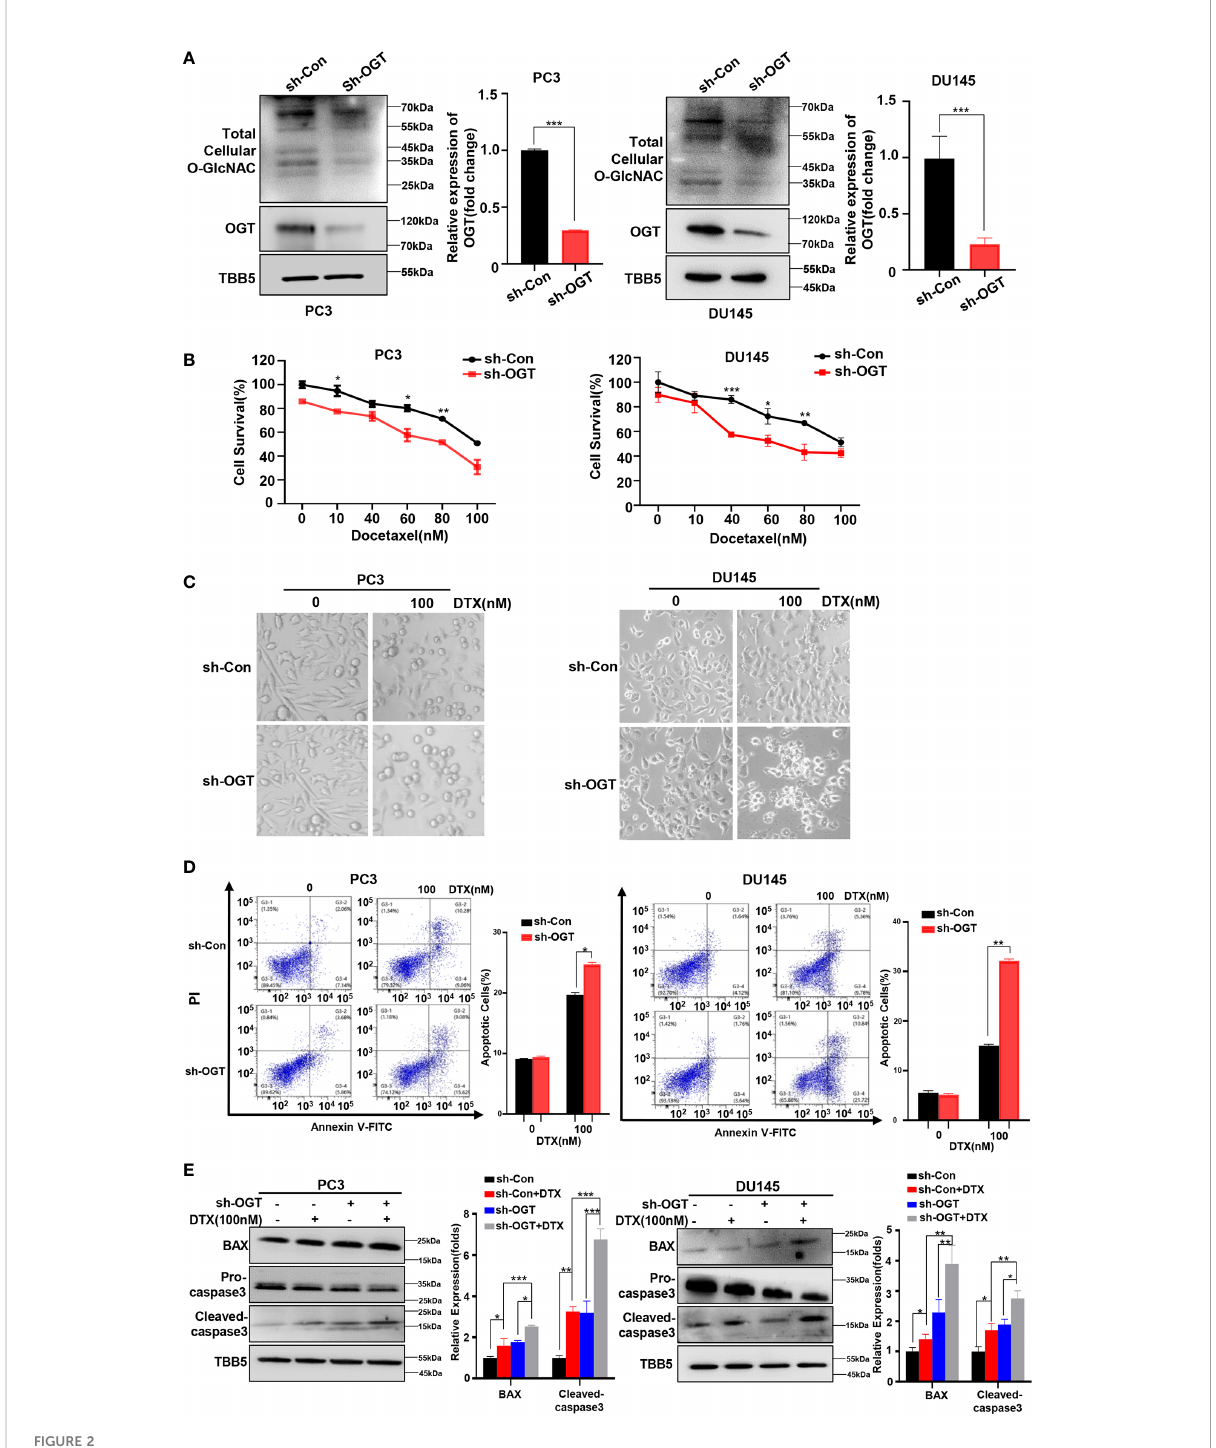
FIGURE 2 Knockdown of OGT sensitizes PC3 and DU145 cells to docetaxel. (A) The down-regulation of OGT and O-GlcNAC by sh-OGT plasmids was detected by Western blotting. (B) CCK8 assays using OGT-KD stable cell lines treated with docetaxel in PC3 and DU145. Data are expressed as the mean ± standard deviation (SD), n=3 per group. (C) Morphological analysis of control and OGT-KD cells treated with different doses of docetaxel. (D) Annexin V/PI staining and fl ow cytometry assay of control or OGT-KD cells with different drug treatments. (E) Western blot (WB) analysis of BAX and caspase-3 in control or OGT-KD PC3 and DU145 cells treated with various concentrations of docetaxel. All statistical data are presented as the mean ± SD. *p < 0.05; **p < 0.01; ***p < 0.001 (Student ’ s